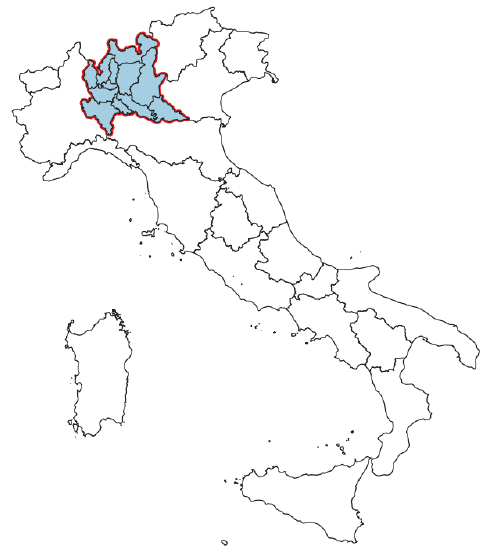
Figure 1. Map of Lombardy, highlighted in red, and its 12 provinces, colored in light